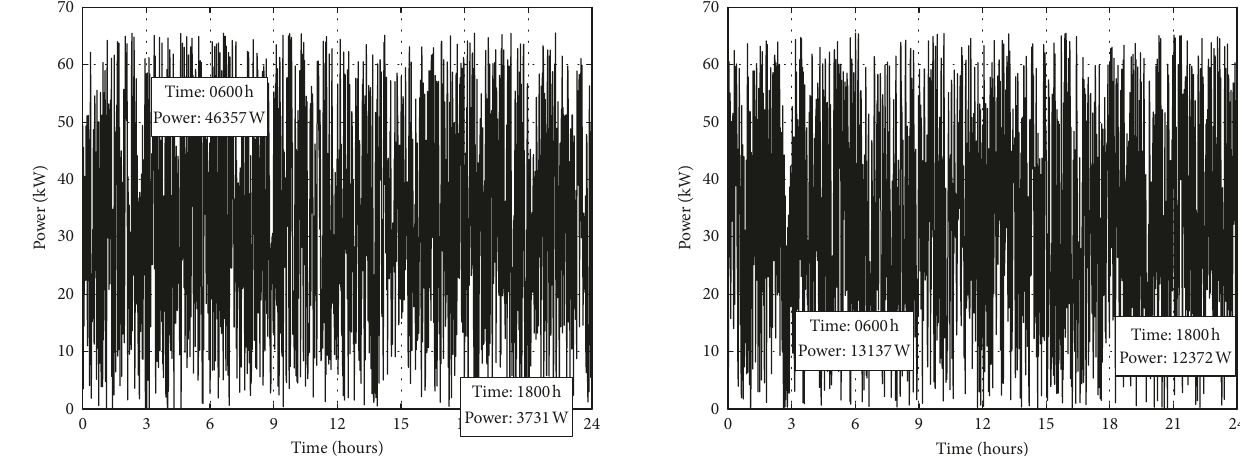
Figure 5: Encryption with Spritz using Key1 .